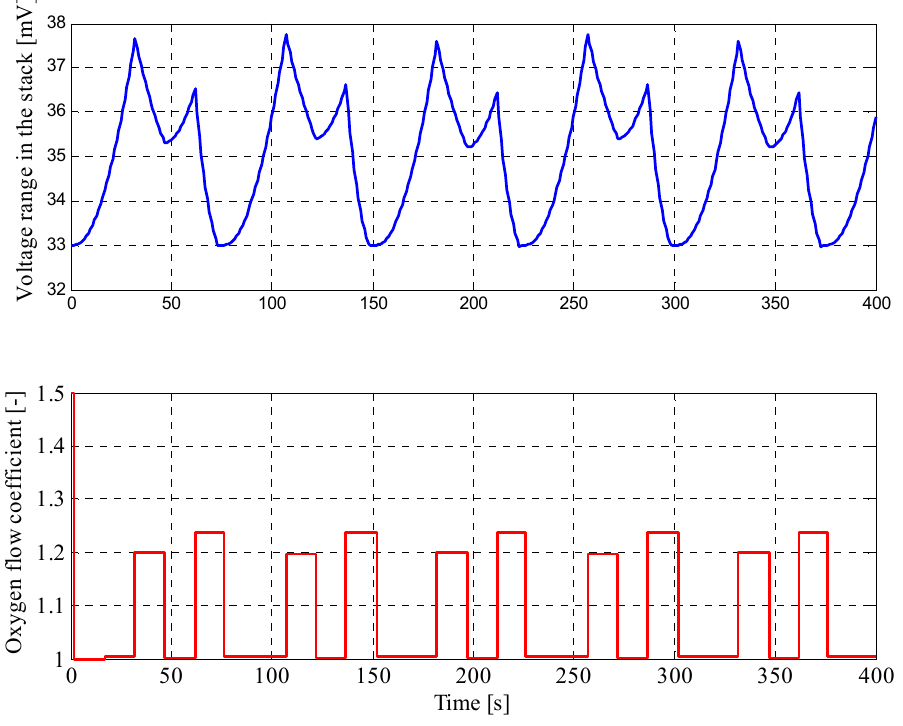
Figure 17. Voltage range and oxygen flow coe ffi cient for the optimized by GA fuzzy control procedure with simulation parameters set to R U , z = 35 mV and ∆ t = 15 s (initial R U = 33 ( mV ) , k O = 1.5 ).